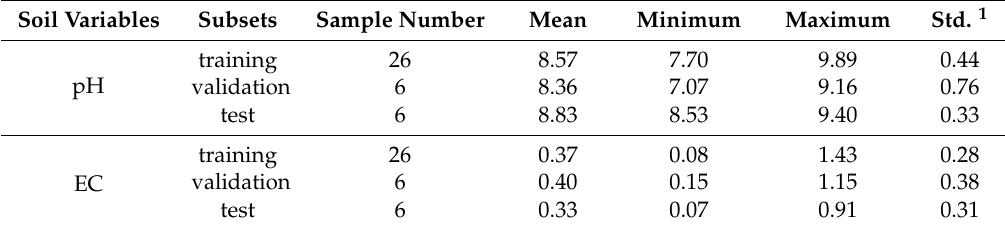
Table 1. pH and electrical conductivity (EC) descriptive statistics of the three subsets in the artificial neural